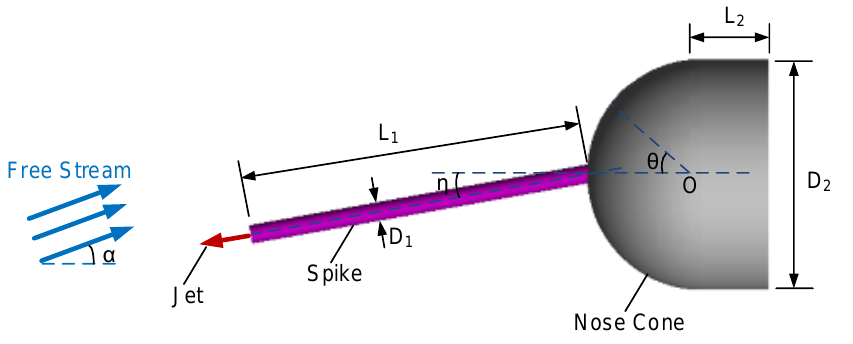
Figure 1. Physical model. Table 1. Sizes of adjustable non-ablative TPS.